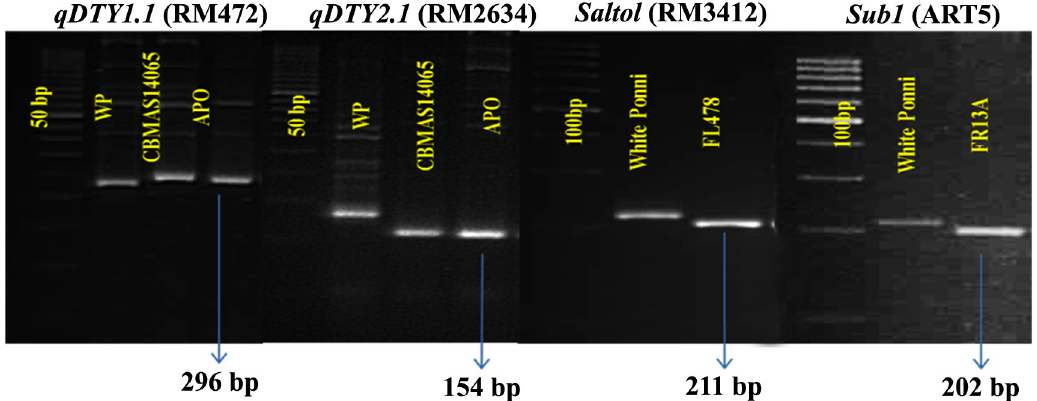
Fig 2. Parental polymorphism for the markers linked to the target